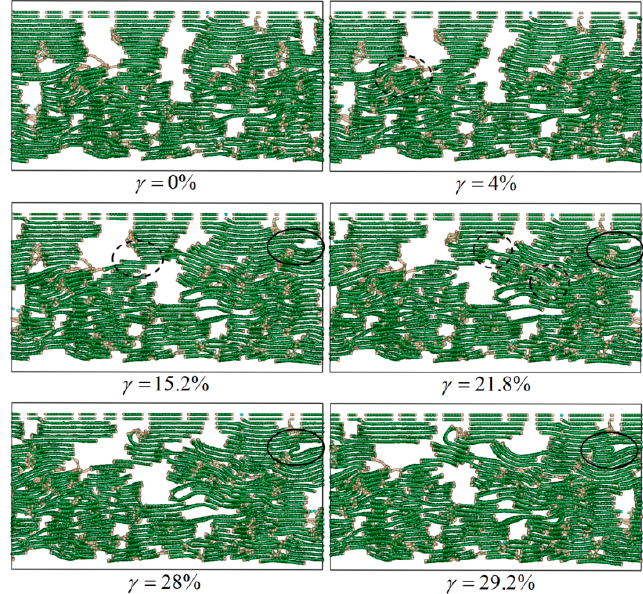
Figure 12. Typical failure modes of the C f /PyC interphase under a tangential shear load when L a = 3 nm .